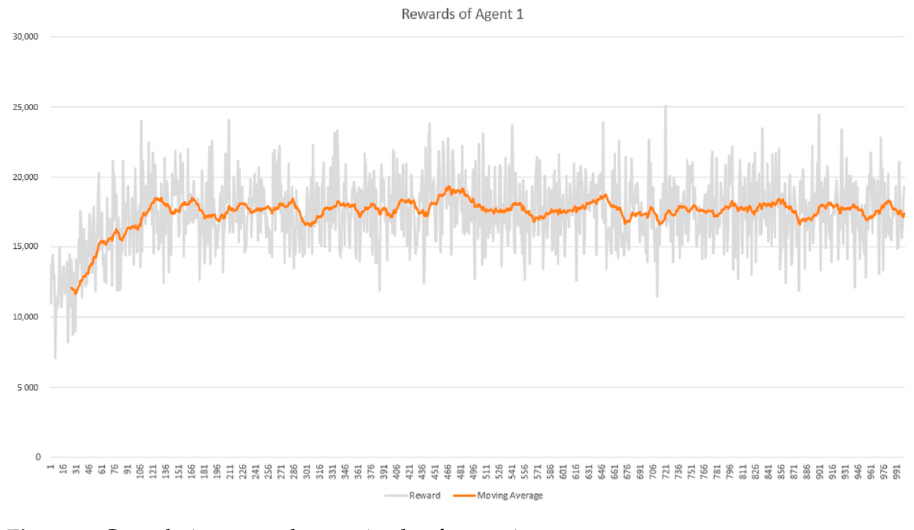
Figure 9. Cumulative reward per episode of agent 1.